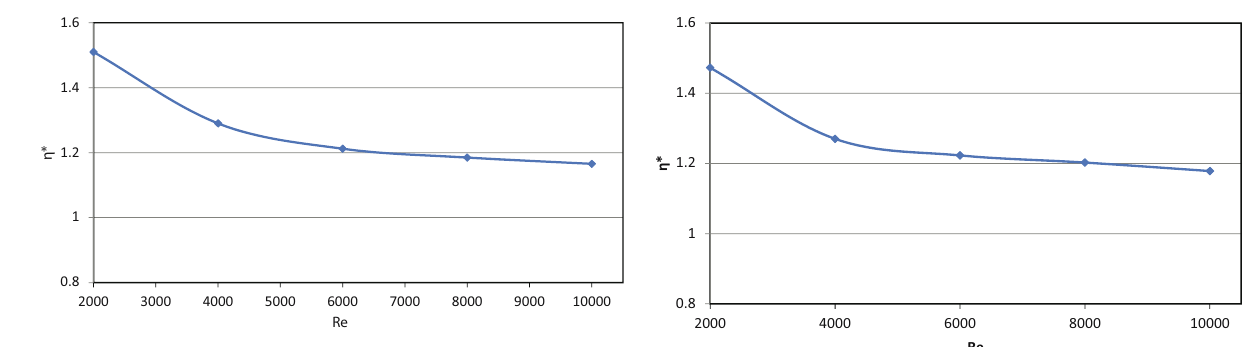
Figure 11: The changes in maximum heat transfer performance ( η * ) versus the Reynolds number in di ff